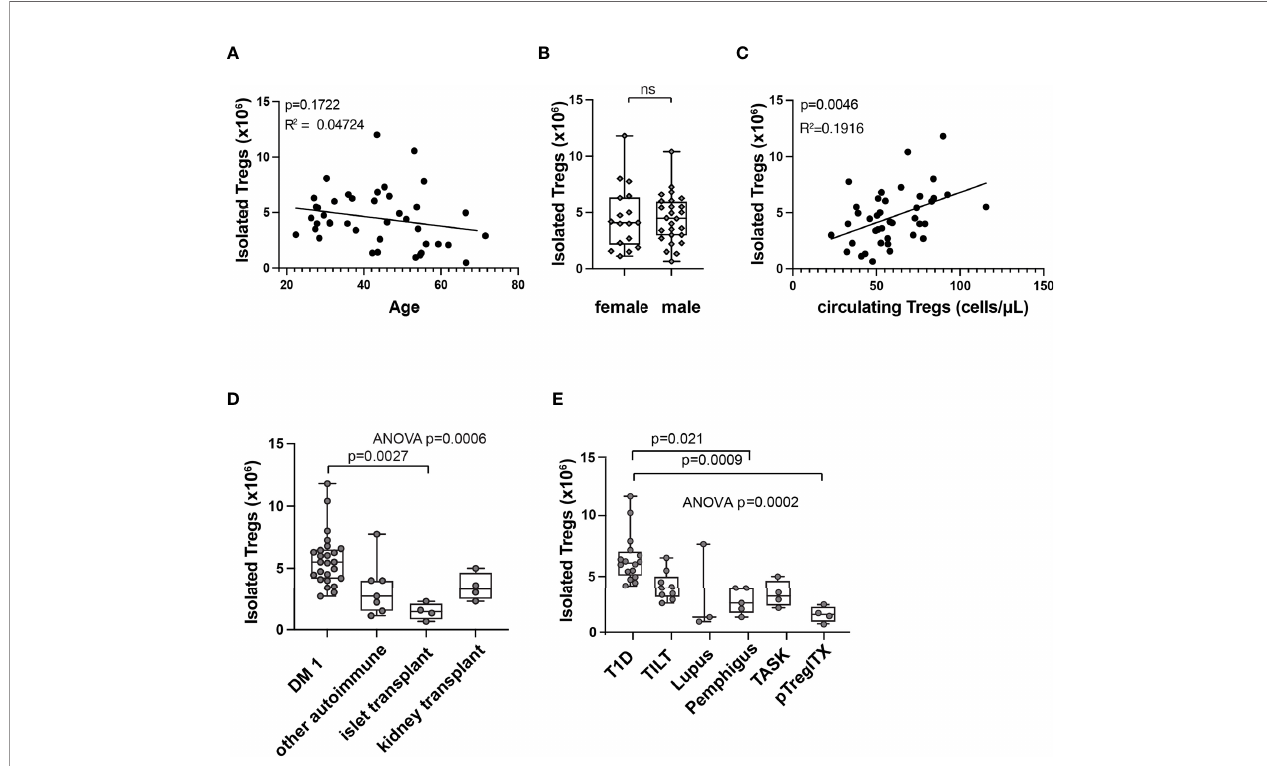
FIGURE 4 | Correlations with isolated Treg numbers at start of manufacturing (day 0). Correlation between patient age (A) , sex (B) , or circulating Treg number (C) and isolated Treg number on day 0 of manufacturing by simple linear regression. R squared (R 2 ) values and p-value assess goodness of fi t, and signi fi cance of slope not equal to zero. Isolated Treg number on day 0 of manufacturing, subcategorized by patient indication (D) or by clinical trial (E) . Means comparison, ns, not signi fi cant. In box and whisker plots, the box shows mean and quartiles, whiskers show minimum and maximum